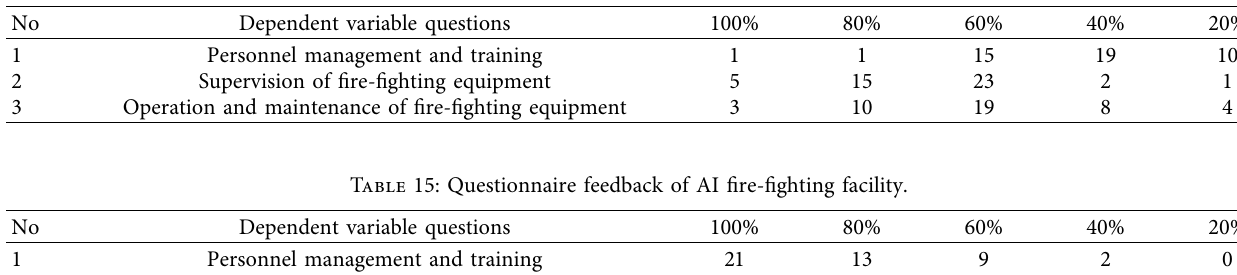
Table 14: Questionnaire feedback of traditional fre-fghting facility.